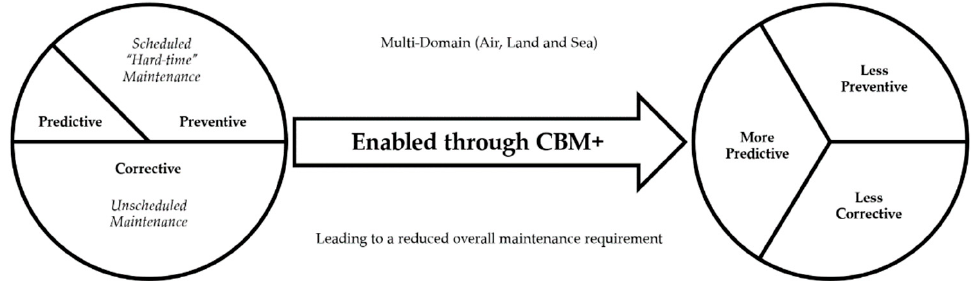
Figure 5. Representative illustration of the United States Department of Defense Maintenance Strategy Transition—“Enabled through CBM+” [80]